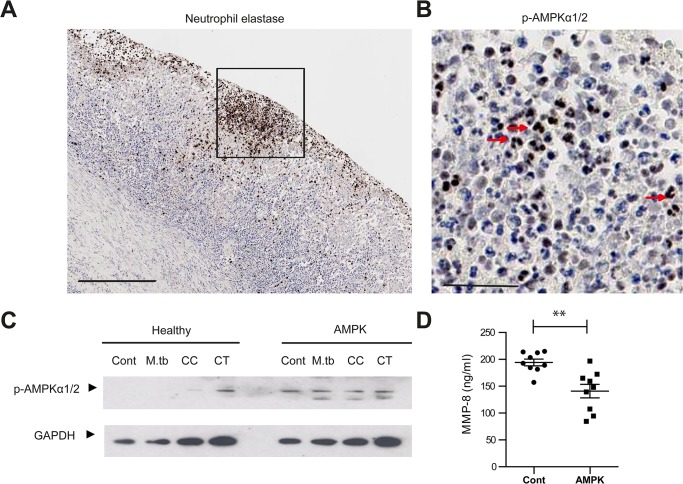
AMPK regulates neutrophil MMP-8 secretion in patients.(A) Neutrophils are present in human TB lung cavity wall and stain positive for neutrophil elastase. Scale bar 250μm. (B) Neutrophils express phospho-AMPKα (T172) in the nuclei (red arrows) (inset of A). Scale bar 50μm. (C) Neutrophils from healthy donors and patients with AMPK deficiency were stimulated with M.tb MOI of 10, CoMCont or CoMTB for 30 minutes. In patients, AMPK is constitutively phosphorylated, resulting in a functional deficiency. Blot representative of 6 healthy controls and AMPK patients. (D) Neutrophils from healthy donors and patients with AMPK deficiency were stimulated with CoMTB. n = 3 both groups. Neutrophils derived from AMPK patients secreted less MMP-8 when stimulated than cells from healthy donors. Experiments were performed in biological triplicates and each point represents a sample. Analysis was performed using one-way ANOVA or two-tailed t-test. ** P<0.01, ***P<0.001.